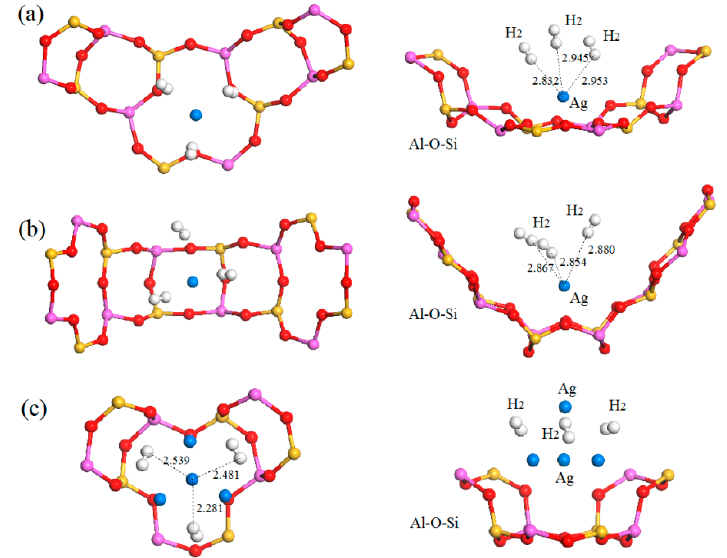
Figure 8. Optimized adsorption configurations and corresponding binding energies of H 2 molecule in ( a ) aAg 0.29 Li 0.71 -LSX, ( b ) bAg 0.43 Li 0.57 -LSX, and ( c ) cAg 0.29 Li 0.71 -LSX. The indicated distance from the adsorbed H 2 molecule to the doped Ag cation is measured in Å. The green, pink, yellow, red, and white balls represent Li, Al, Si, O, and H atoms respectively.